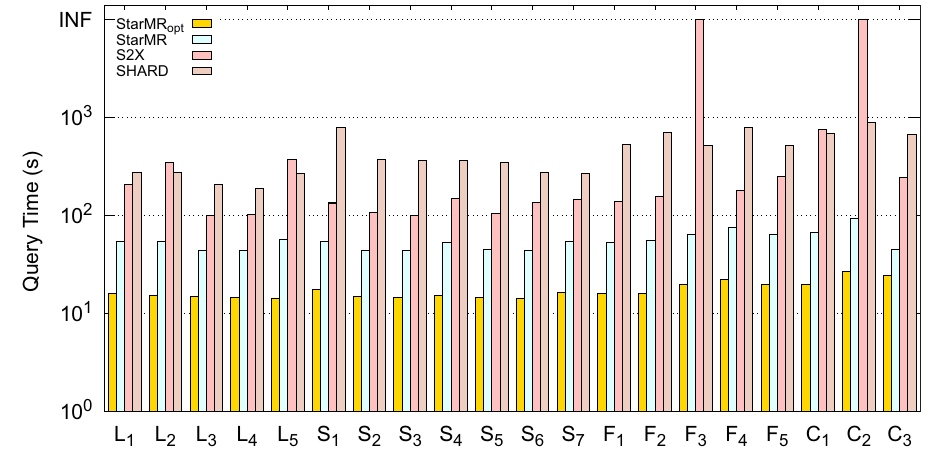
Fig. 5 The results on different queries over